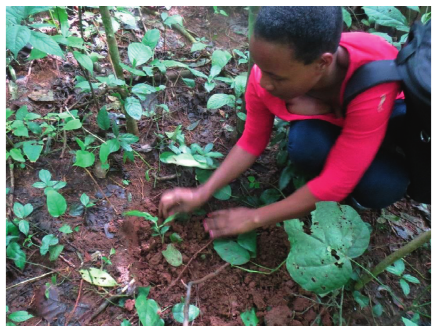
Figure 4: Seedling planting in the